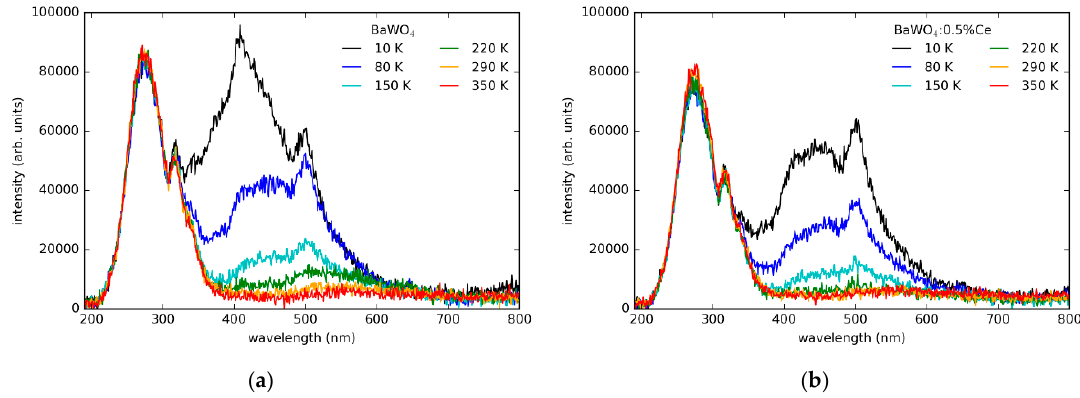
Figure 9. Radioluminescence spectra of BaWO 4 ( a ) and BaWO 4 : 0.5 at. % Ce ( b ) single crystals.